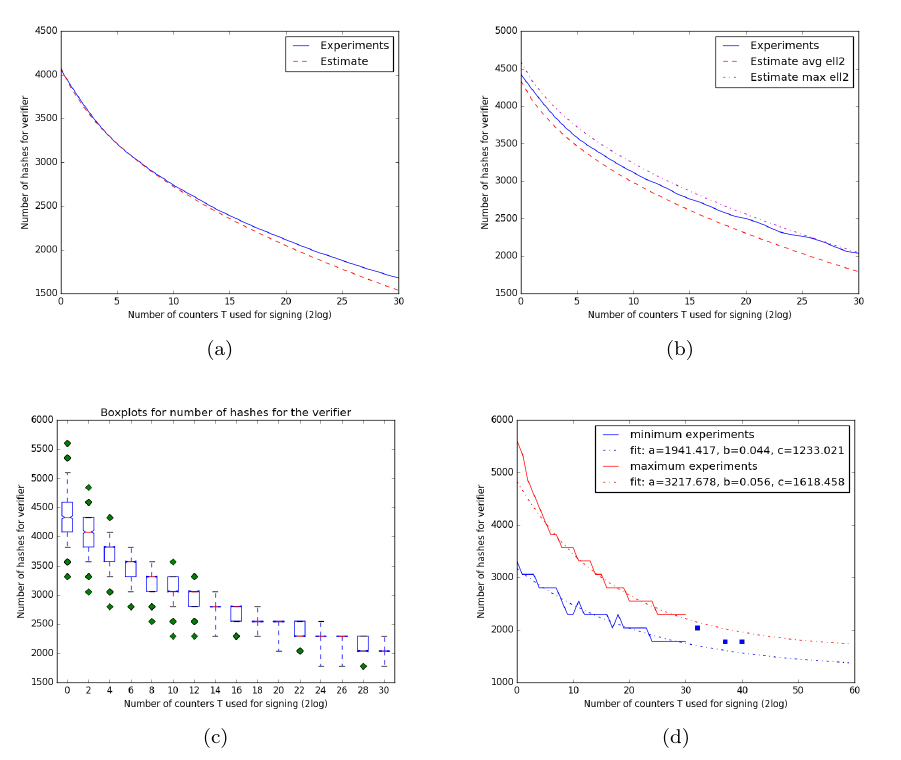
Figure C.1: Experiments of Section 6 for w = 256. a) Average number of hash computations for the signature verification of the first ‘ 1 message chains, b) Average number of hash computations for the signature verification for all ‘ = ‘ 1 + ‘ 2 chains, c) Boxplot of the number of hashes for the verifier in the ‘ chains, after applying T = 2 t counters and taking the best cumulative total of the chains, and d) Min/Max of number of hashes for the verifier in the ‘ chains, after applying T = 2 t counters and taking the best cumulative total of the